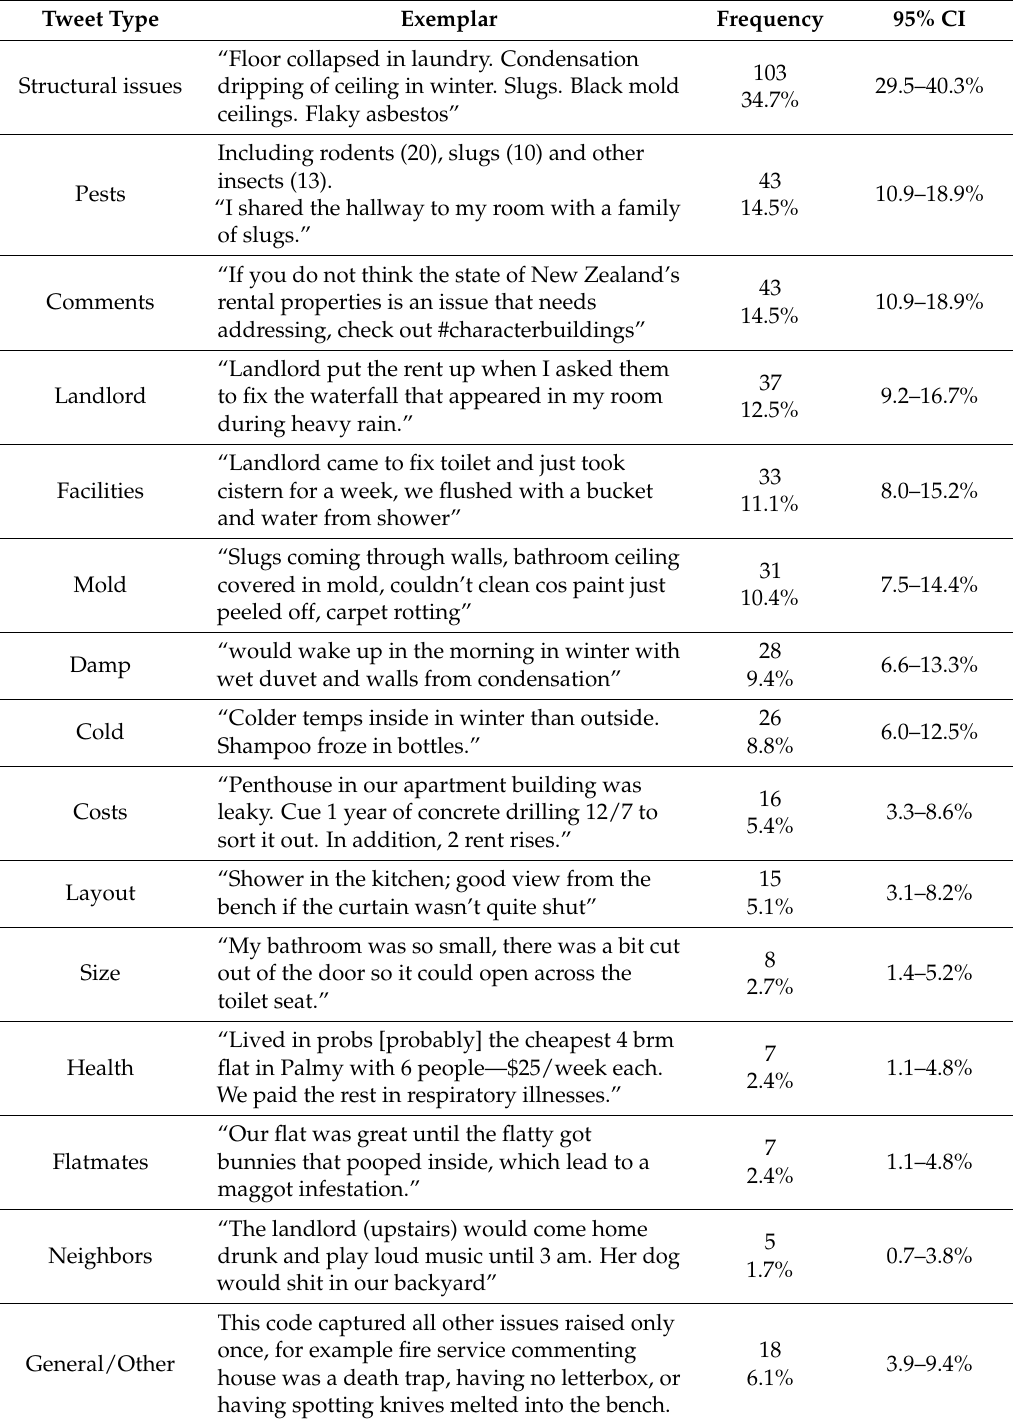
Table 1. Categories of #Characterbuildings Tweets